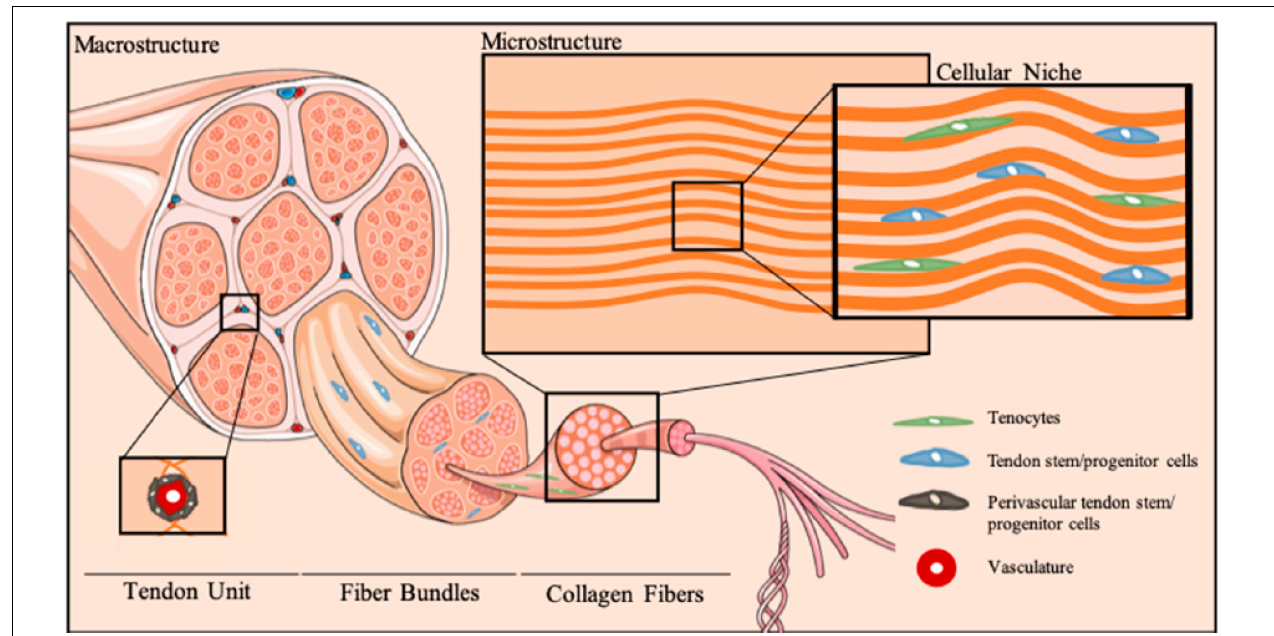
FIGURE 9 | Cellular niche of tendon tissue. Tenocytes and relative stem cells can be found in the tendon (Costa-Almeida et al.,